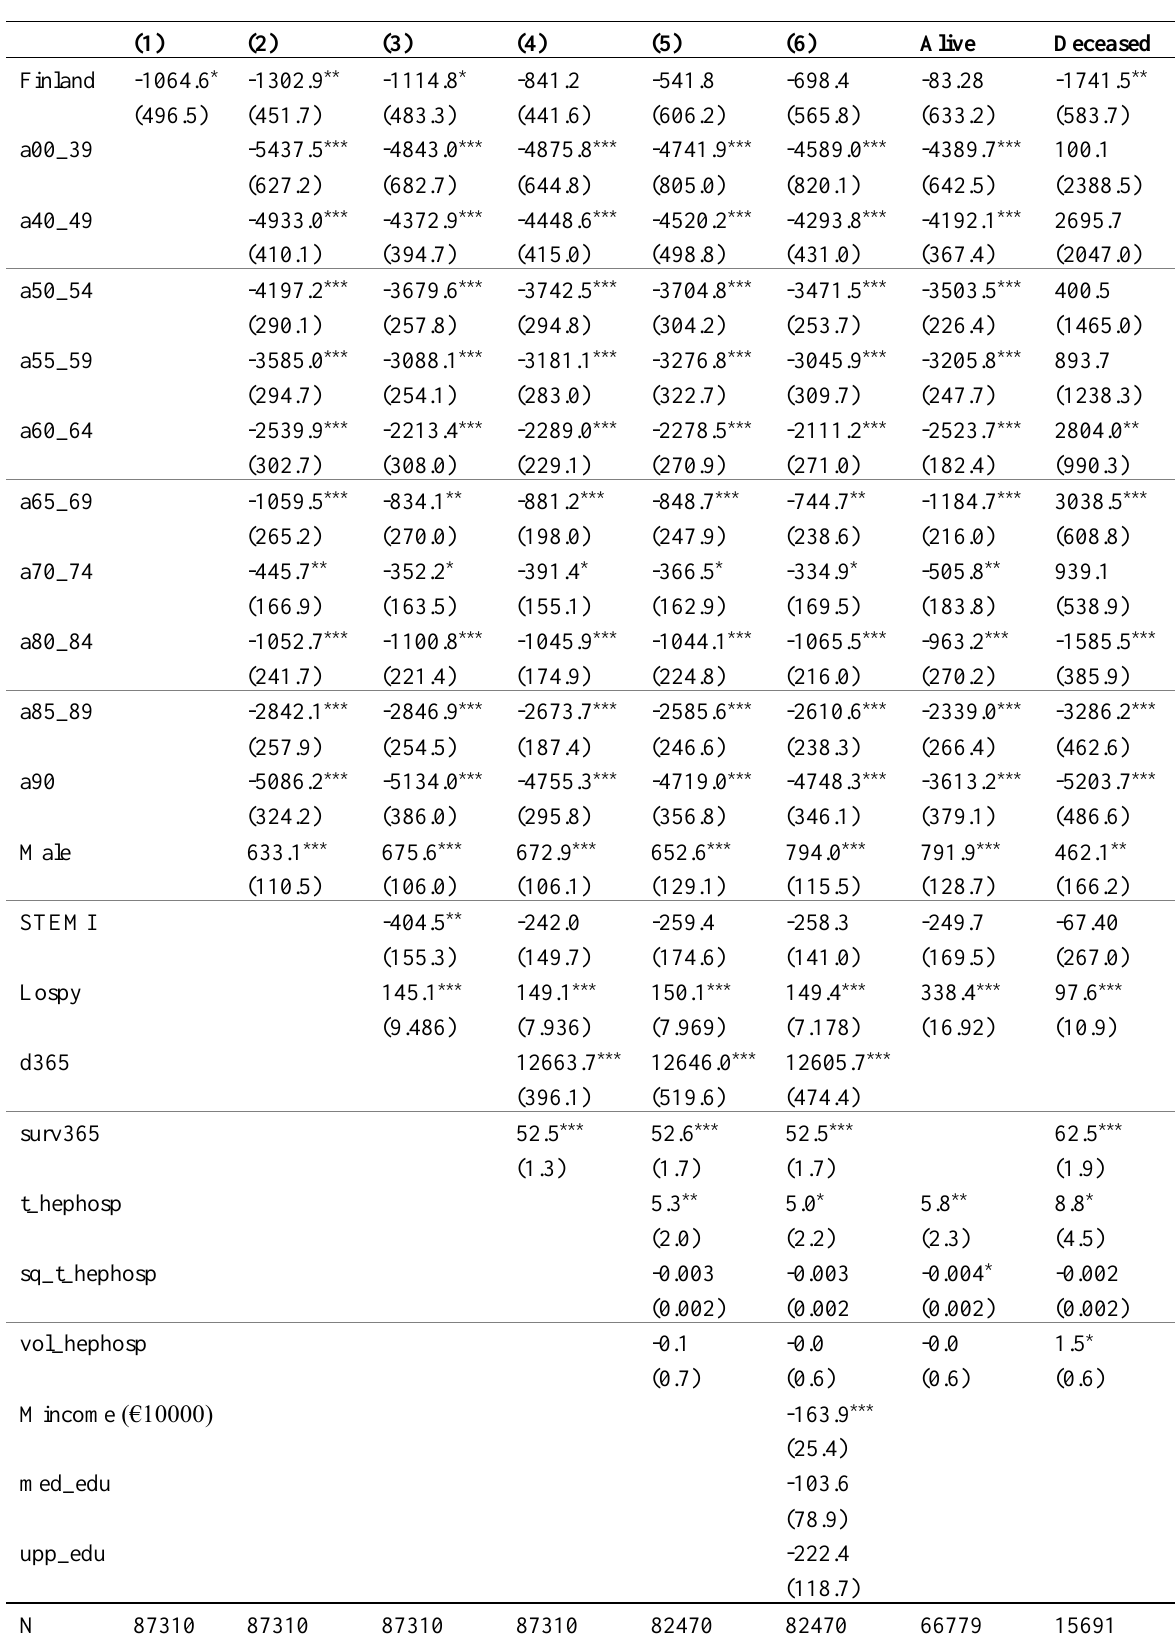
One-year cost comparison in euro by GLM log Poisson total and according to mortality status (by OLS) with year fixed effects (patients admitted 2009 – 2013). Bootstrapped standard errors with 100